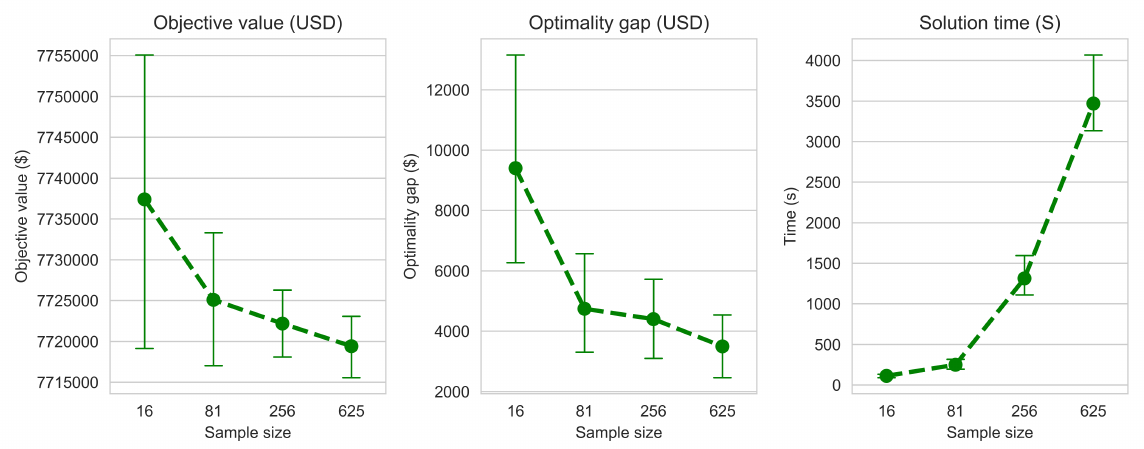
Figure 2. Performance measurement of SAA for harvest scheduling. Error bars indicate 95% confidence interval.